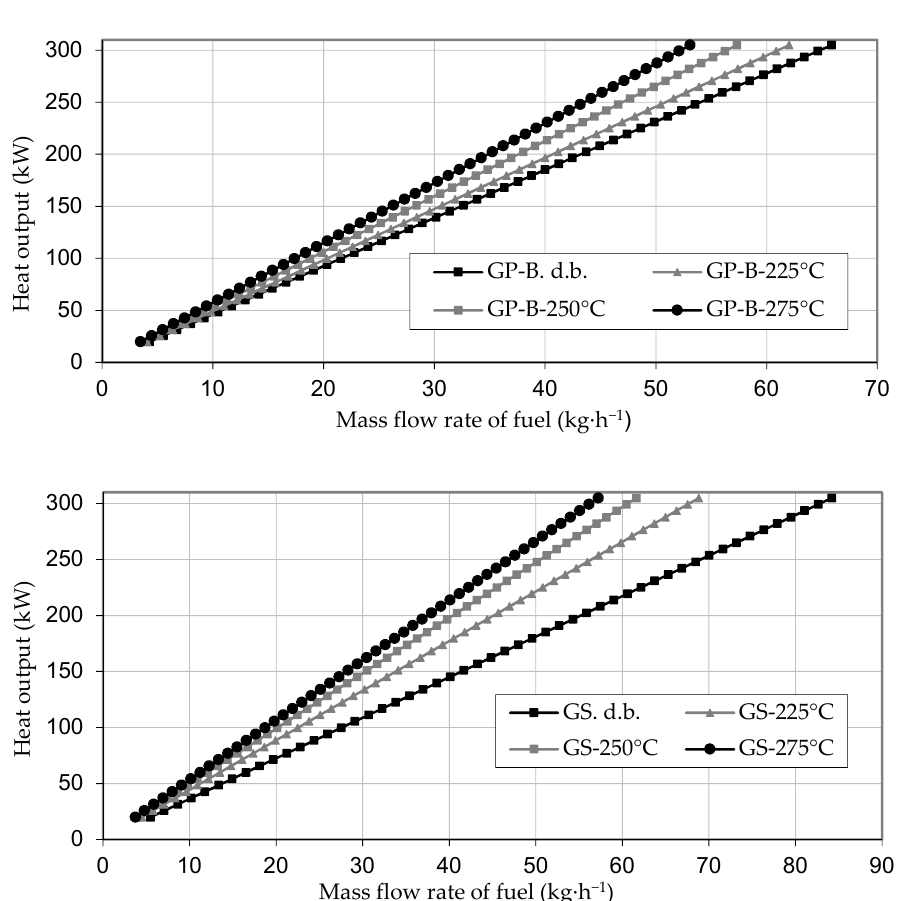
Figure 2. The mass flow rate of fuel to a combustion device for given heat output.